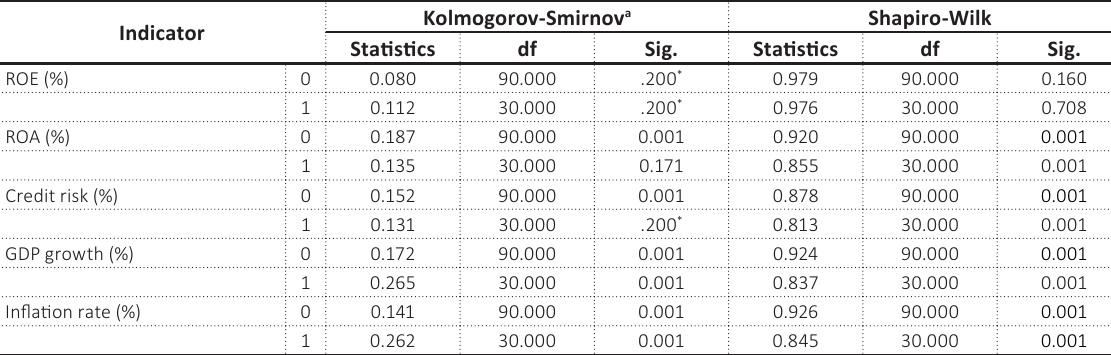
Table 3. Normality test – Philippines vs Malaysia Indicator